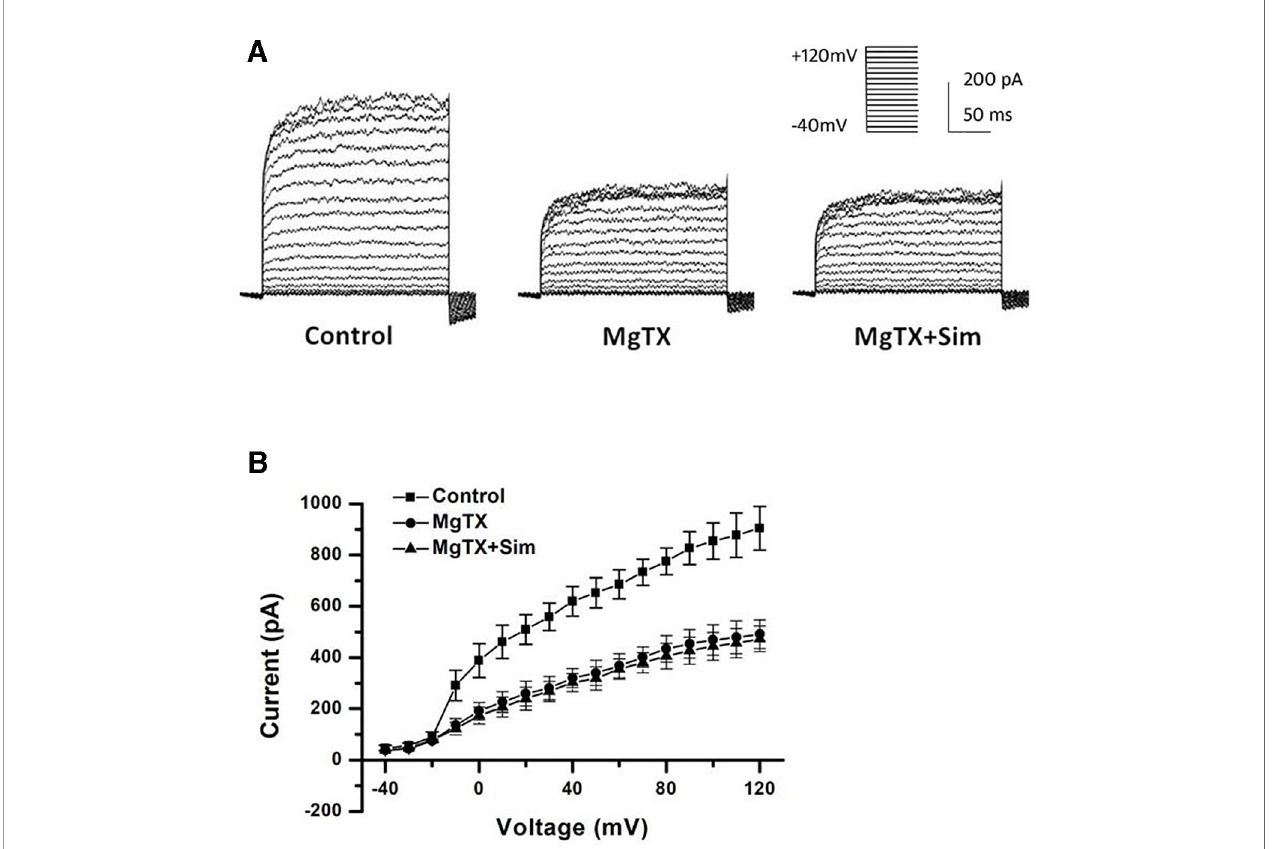
FIGURE 5 | Simvastatin sensitive components of KCa3.1 current recording above − 40 mV was identi fi ed in THP-1 cells measured by whole-cell clamp patch. (A) The THP-1 cell was held at − 40mV and received the test potentials from − 120 to +40 mV; the currents were detected by using an electrode with 1 µM free Ca 2+ . (B) Average current density-voltage relationships before and after application of 1 nM MgTX and 10 µM simvastatin was indicated (n = 4 for each